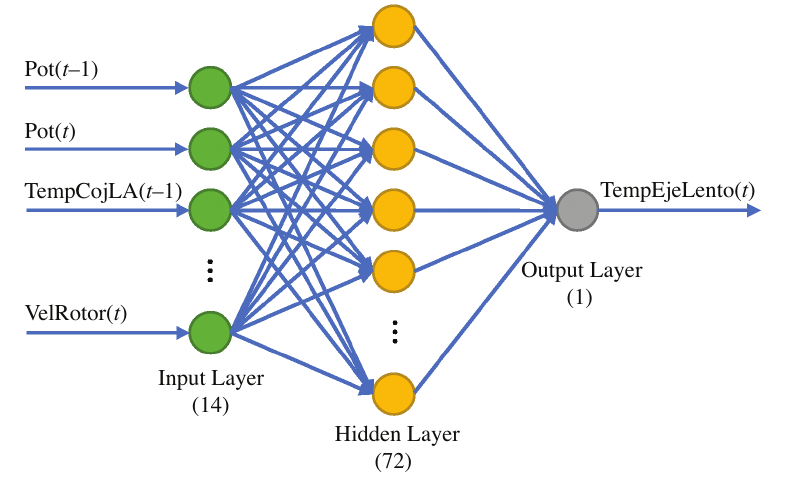
Figure 13. ANN model with 14 inputs, 72 neurons in the hidden layer, and 1